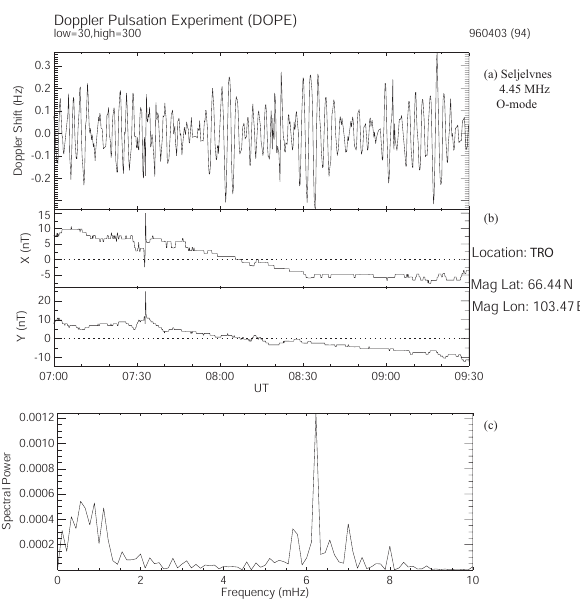
Figure 3. Fig. 3. ( a ) The filtered O mode DOPE trace from Fig. 2 and ( b ) conjugate ground magnetometer data (X and Y components) from the TRO magnetometer. Panel ( c ) indicates results from a spectral analysis of the DOPE data and indicates the presence of a 6-mHz wave in the ionosphere. The wave is classed as uncorrelated, as there is no signature of it in the magnetometer